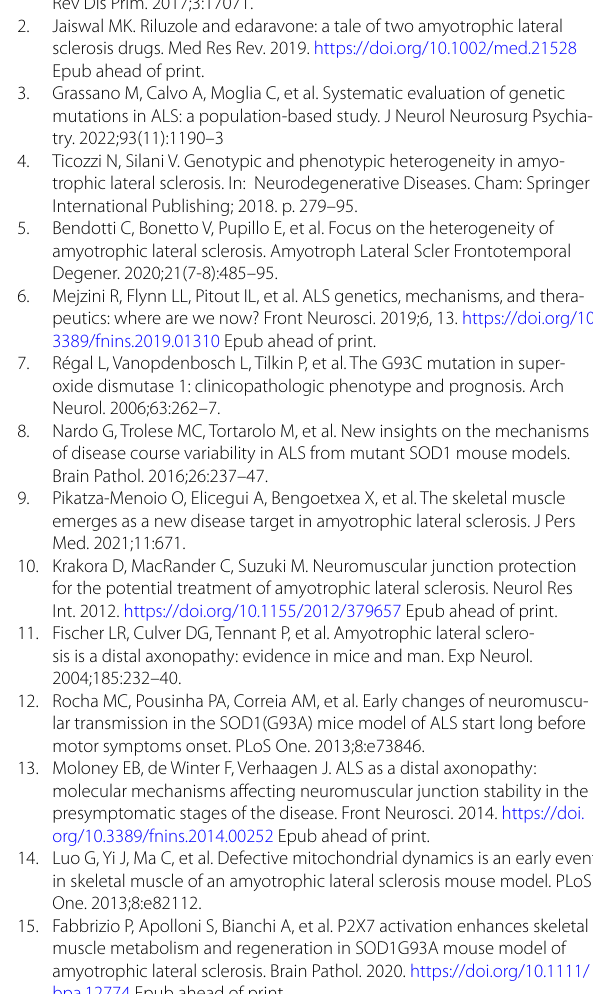
Figure 3. Ex-vivo muscle-derive satellite cells proliferation in fast and slow-progressing mice. Supplementary Figure 4. Muscle fibre composi- tion of the two ALS murine models. Supplementary Figure 5. Muscle inflammatory signals in fast- and slow-progressing